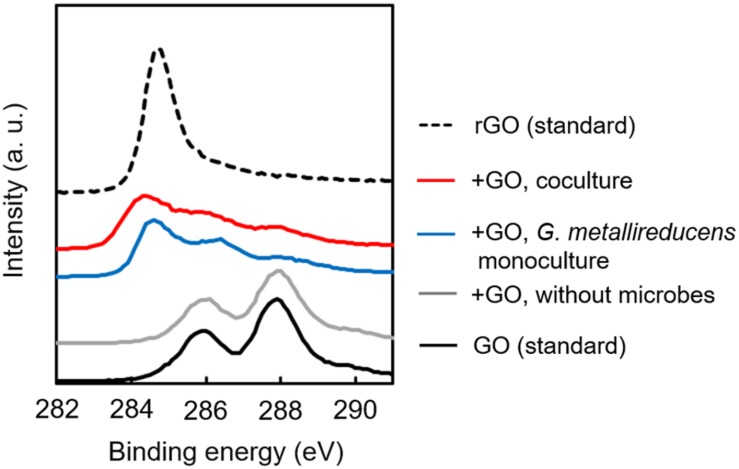
X-ray Photoelectron Spectroscopy spectra of GO-based materials. Dried specimens of GO-based materials collected from culture media before and after cultivation were analyzed by XPS. Binding energy of 284–285, C–C bond; 286, C–OH bond; 288, C=O bond.